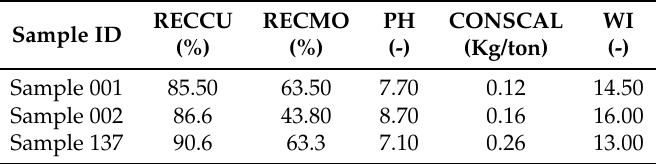
Table 1. Measurements for some samples in the available